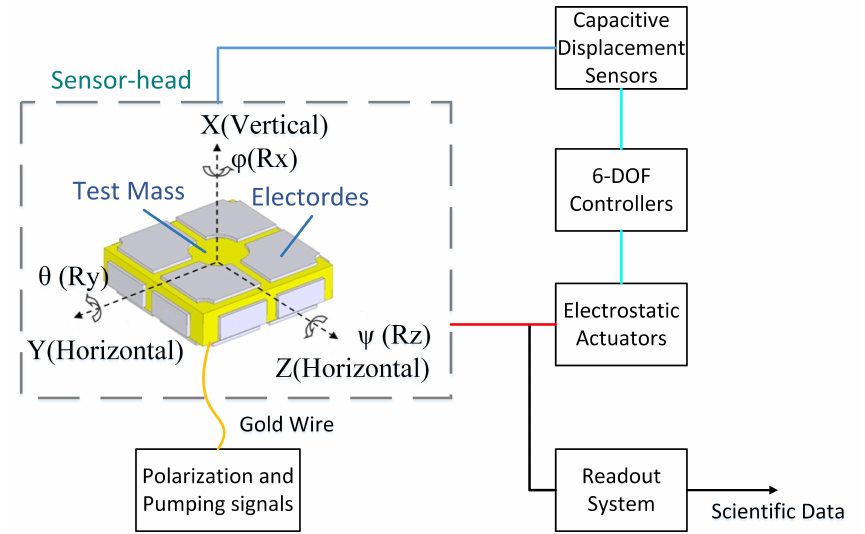
Figure 1. Systematic diagram of an electrostatic accelerometer, where the coordinate system, including three translational axes of vertical (X) and horizontal (Y and Z), and three rotational axes, are